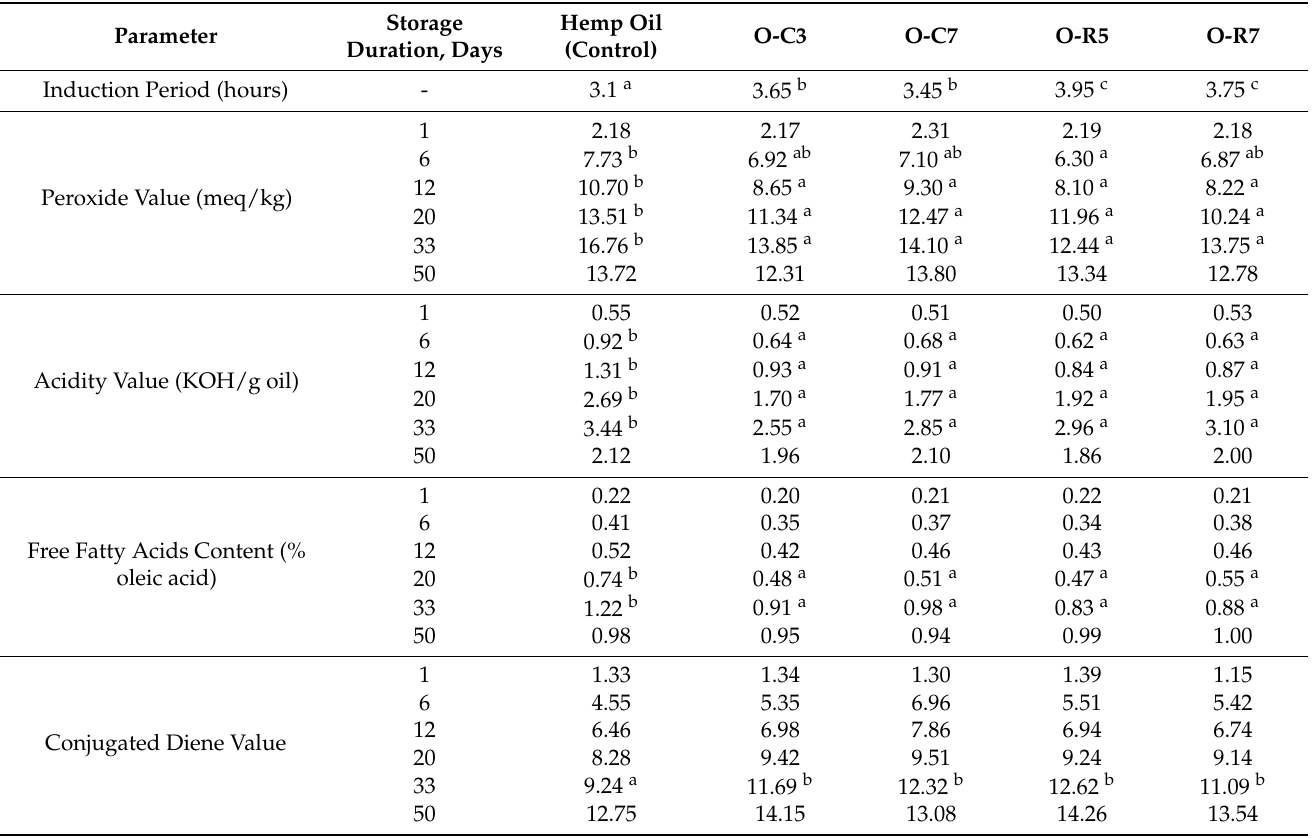
Table 2. Values of parameters showing chemical stability of the hemp oil and